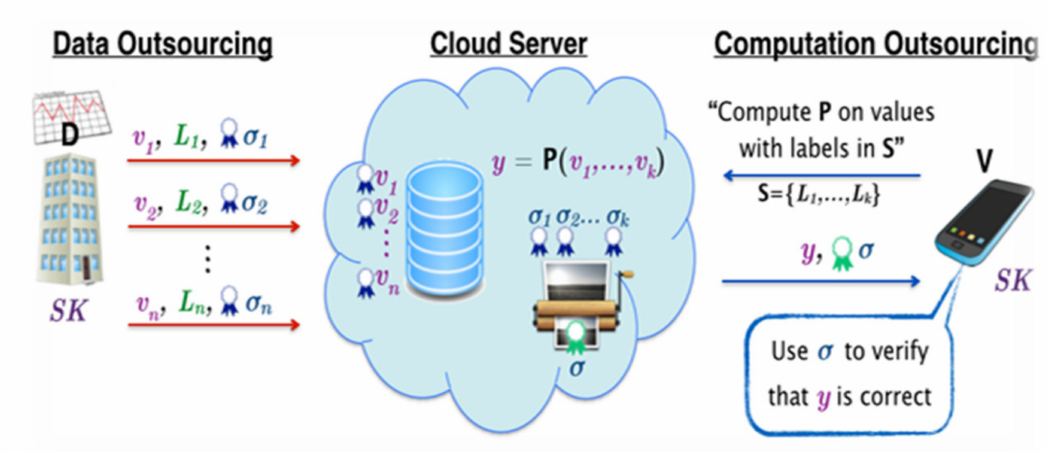
Figure 2. Verifiable Fully Homomorphic Encryption